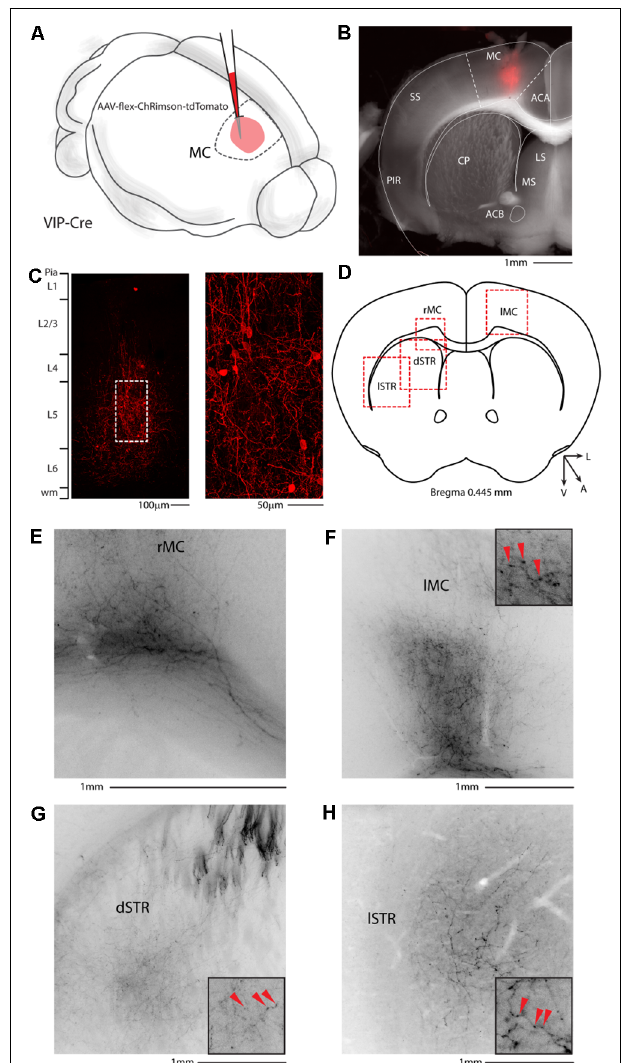
FIGURE 8 | Motor cortex injection of AAV-flex-ChRimson-tdTomato. (A) Schematic representation of right motor cortex viral injection. ( B) Representative coronal section of an acute slice of the injection site (200 µ m thick), with bright field (gray) and tdTomato expressing neurons (red). The Allen brain atlas coronal table superimposed for reference indicates the correct targeting of the motor cortex. Scale bar: 1 mm. The image of the injection site showing no evidence of ChRimson-tdTomato deposit or spillover in the striatum and/or other subcortical structures. (C) High magnification confocal image of the injection site showing tdTomato expressing neurons. Right panel: high magnification of dashed square in the left panel. Scale bars: 100 and 50 µ m. (D) Allen Brain reference coronal section at +0.445 mm from Bregma. Red dashed squares indicate the regions imaged in the panels below. (E) Representative image of the contralateral motor cortex. (F) Representative image of white matter infiltrating axons in correspondence to the injection site. (G) Representative image of dorsal motor striatum with thick axons of passage in the upper striae and terminal field axonal arborization in the striatal parenchyma. (H) Representative image of lateral motor striatum VIP axons. Scale bars: 1 mm. Insets indicate axonal branches and the red arrowheads boutons. Inset size 190 µ m. ACA, anterior cingulate cortex; MC, motor cortex; SS, somatosensory cortex; PIR, piriform cortex; STR, striatum; CP, caudoputamen; ACB, nucleus accumbens; LS, lateral septal nucleus; MS, medial septal nucleus; dSTR, dorsal striatum; lSTR, lateral